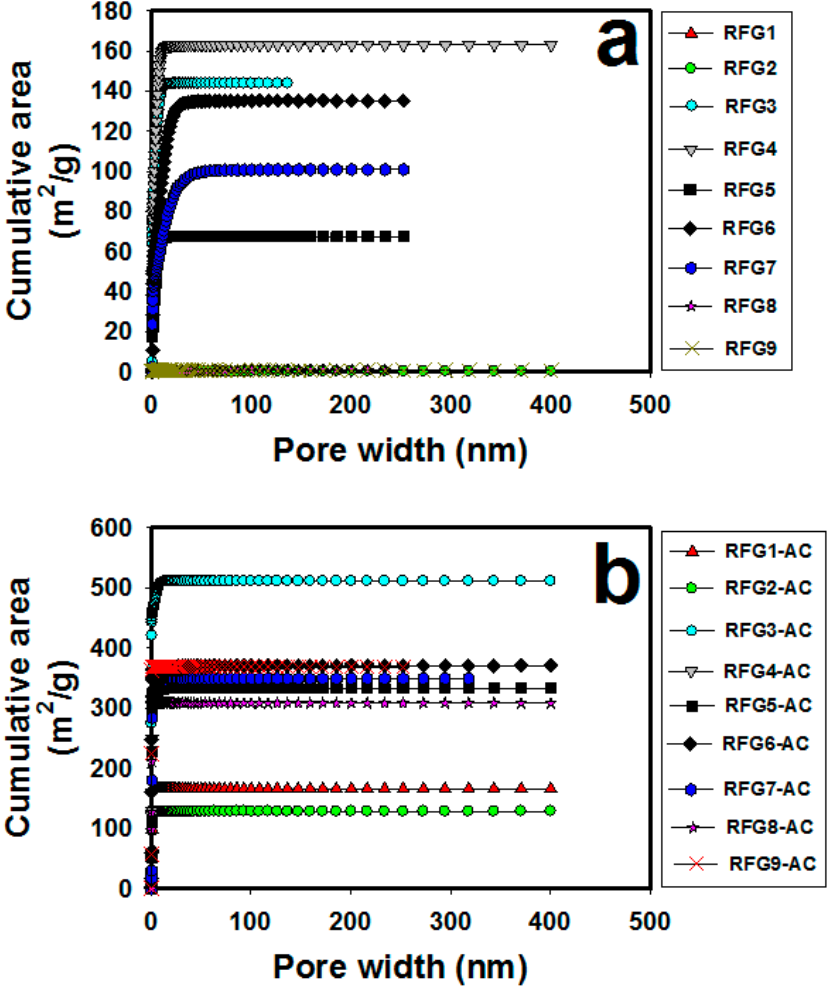
Figure 8. Cumulative pore area versus pore width of ( a ) RFG n and ( b ) RFG n -AC samples.